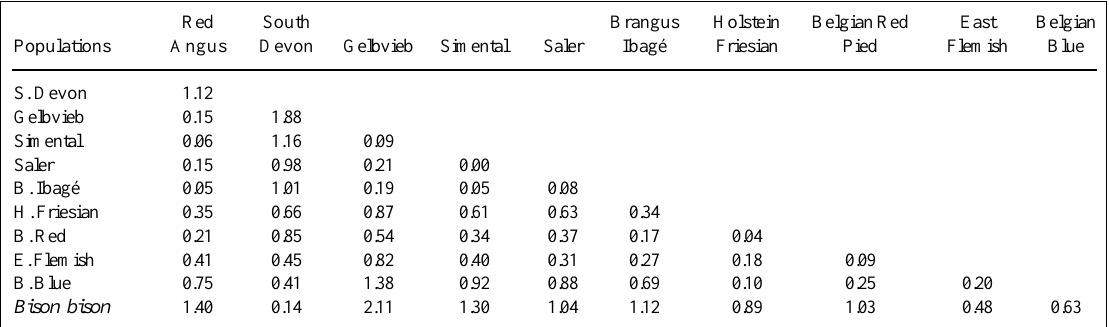
Table IV - Genetic distance matrix obtained with D sw distance based on TGLA122 locus in 11 bovine populations.